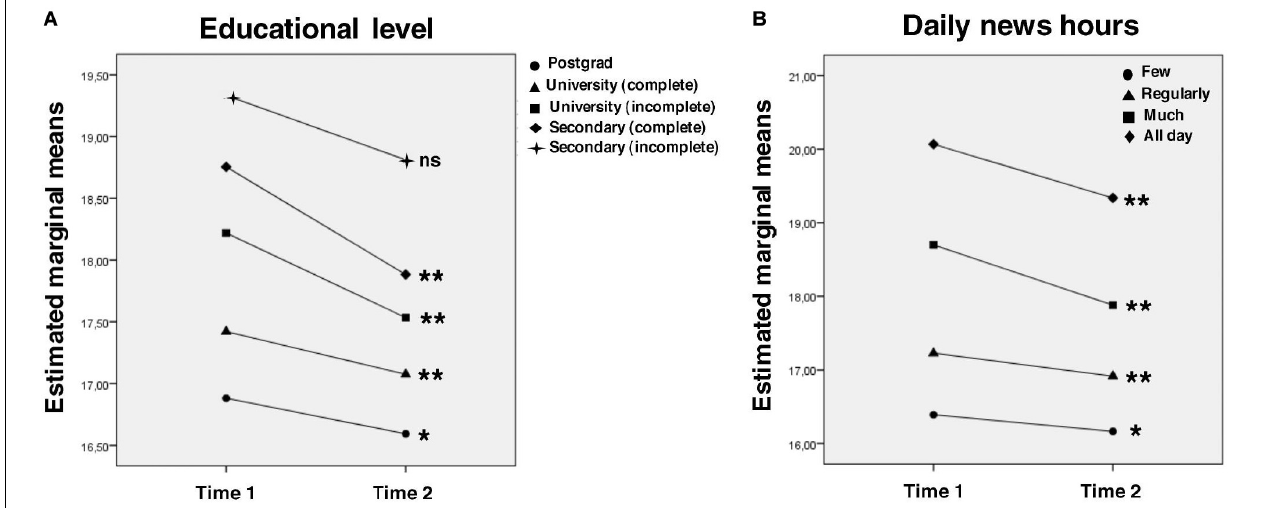
FIGURE 2 | Interaction effects for negative affect. Intragroup analysis with Bonferroni correction are expressed in the graphs: line-group with ∗ showed p < 0.05 intragroup differences between time 1 and time 2; line-group with ∗∗ showed p < 0.01 intragroup differences between time 1 and time 2; line-group with ns showed no statistical intragroup differences between time 1 and time 2. Post hoc intergroup comparisons with Bonferroni correction (only significant differences are considered, all the comparisons missing were not statistically significant; ∗ p < 0.05, ∗∗ p < 0.01): (A) Time 1: secondary (incomplete), postgrad ∗ ; secondary (complete), university (complete) ∗∗ ; secondary (complete), postgrad ∗∗ ; university (incomplete), university (complete) ∗∗ ; university (incomplete), postgrad ∗∗ . Time 2: secondary (incomplete), postgrad ∗ ; secondary (complete), postgrad ∗∗ ; university (incomplete), postgrad ∗∗ . (B) All the intergroup comparisons were statistically significant ∗∗